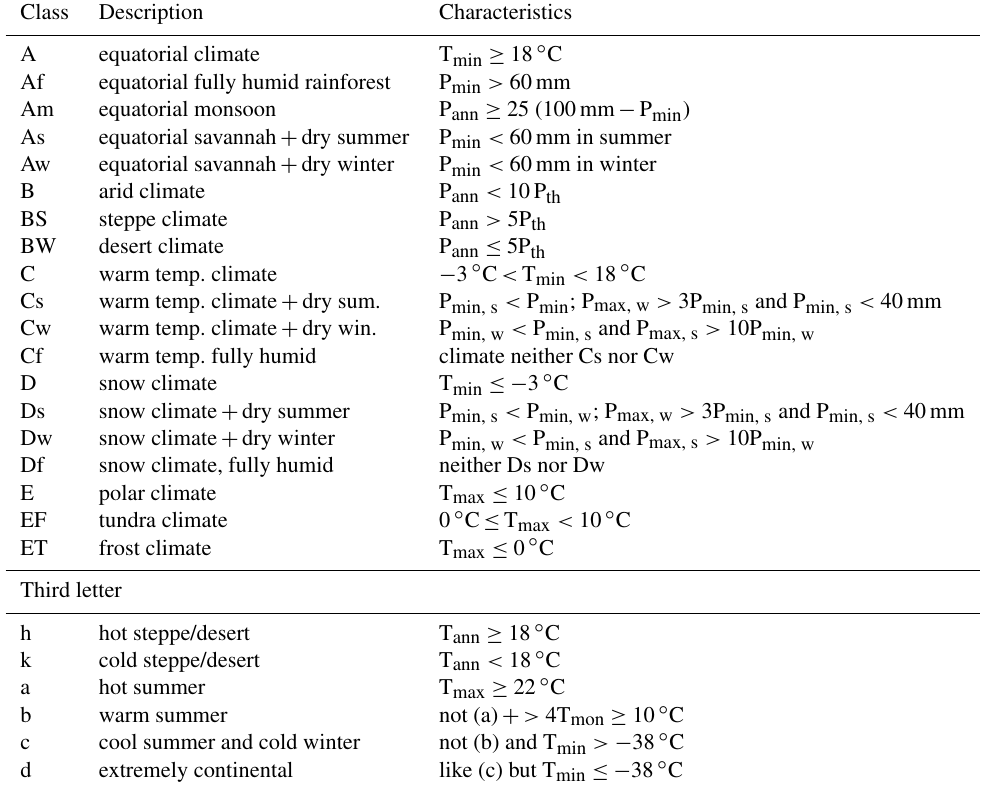
Table A2. Description of Geiger–Köppen climate classes after Kottek et al. (2006) defined by temperature (T) and precipitation (P) (with P th being a dryness threshold and subscripted s and w denoting summer and winter values, respectively; see Kottek et al., 2006, for